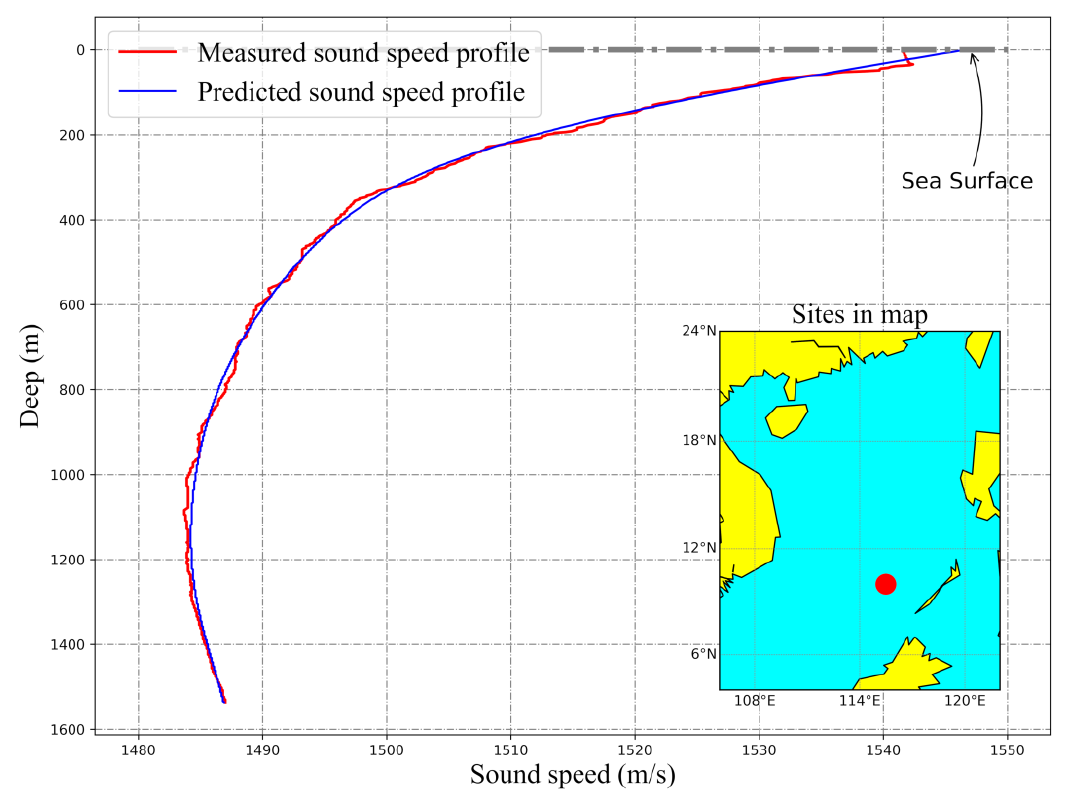
Figure A1. Optimized BP network predicted results at 12 sites.